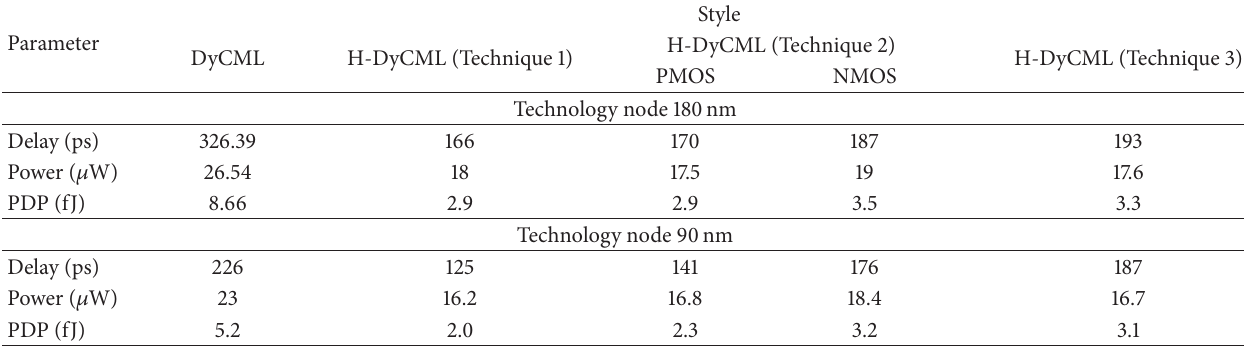
Figure 10: Performance of two-input H-DyCML XOR gate by varying the aspect ratio of the transistors in the CPL network: (a) delay results; (b) power results. Table 5: Performance comparison of the existing DyCML and the proposed H-DyCML 3-input XOR gate with single level of source-coupled transistors in the